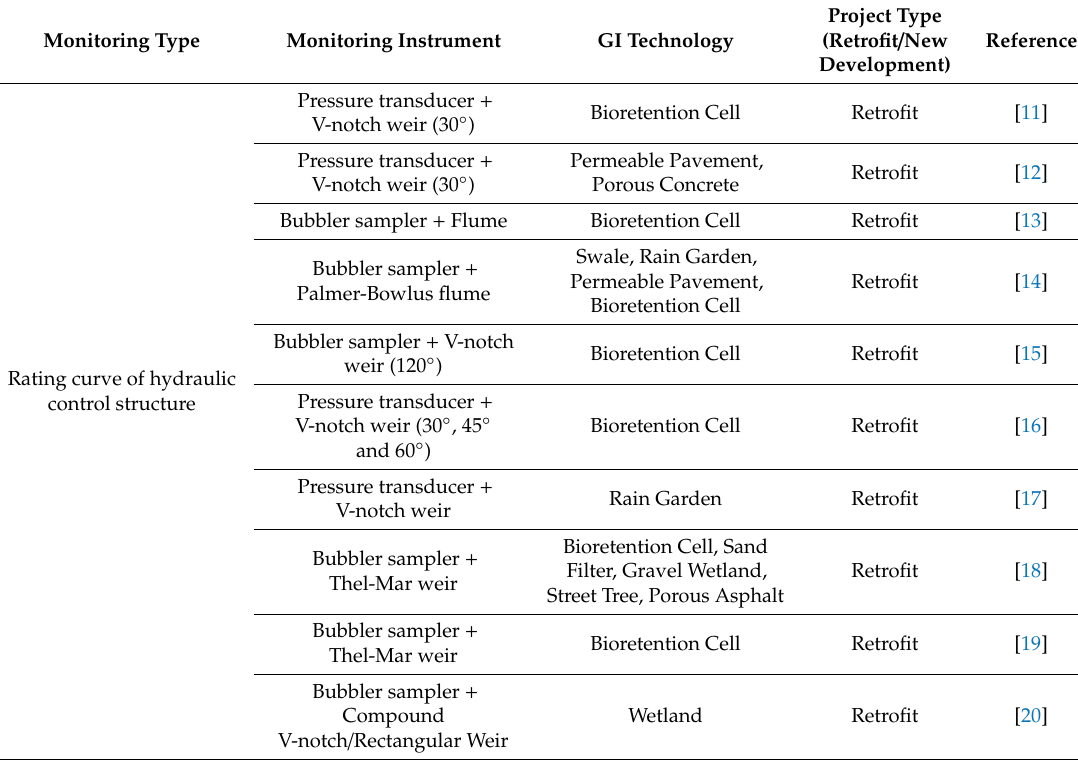
Table 1. Summary of literature case studies involving full-scale Green Infrastructure (GI) hydrological